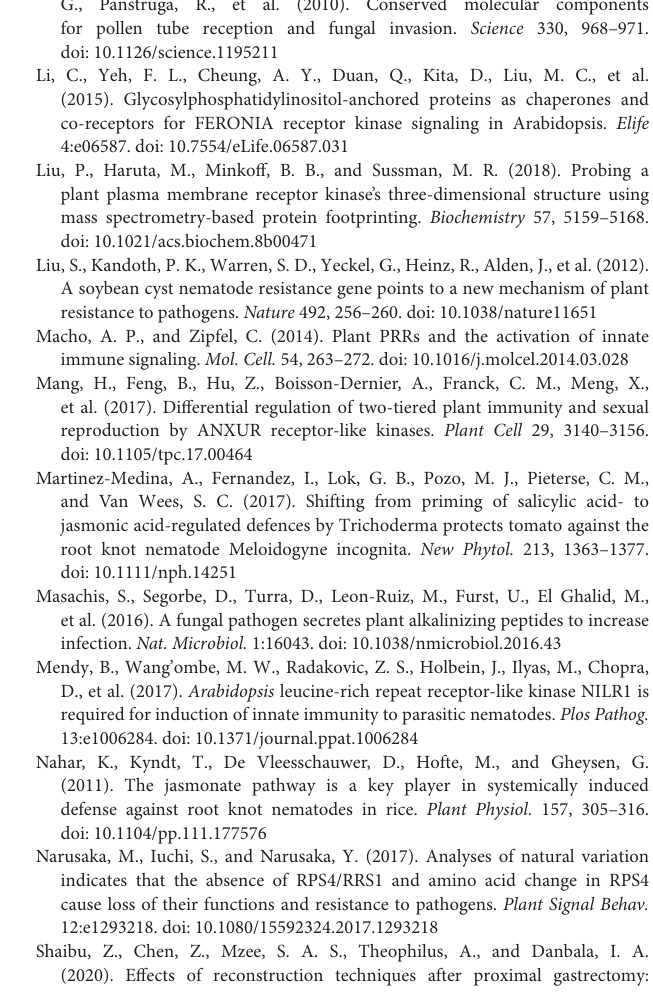
Supplementary Figure S1 | Alignment of GmLMM1 and FER. (A) Gm LMM1 protein domain. Two corresponding mutated sites in rmi1 and rmi2 are indicated. (B) Alignment of extracellular domain (ECD) sequences of GmLMM1 and FER. Supplementary Figure S2 | Neighbor-joining phylogenetic analysis of GmLMM1 and Arabidopsis Cr RLK1L family. Supplementary Figure S3 | Motif-GO enrichment analysis. (A) Motif-GO enrichment analysis based on the promoters of the DEGs under the infection with M. incognita . (B) GO enrichment analysis based on the p -values for similarly expressed genes corresponding to the DEGs of (A) . The numbers in brackets represent the number of genes. GO category red stained was involved in RKN resistance. (C) Motif-GO enrichment analysis based on the promoters of the DEGs with the mutation of GmLMM1. (D) GO enrichment analysis based on the p -values for similarly expressed genes corresponding to the DEGs of (C) . The numbers in brackets represent the number of genes. GO category red stained was involved in RKN resistance. Supplementary Figure S4 | Neighbor-joining phylogenetic analysis of GmRALFs and Arabidopsis RALF1/23. Supplementary Figure S5 | GST pull-down assay of GmRALFs with GmLMM1. GST-GmLMM1 ECD pulled down the GmRALFs. Anti-His antibody and anti-GST antibody were used to detect the GmRALFs and GmLMM1, respectively.